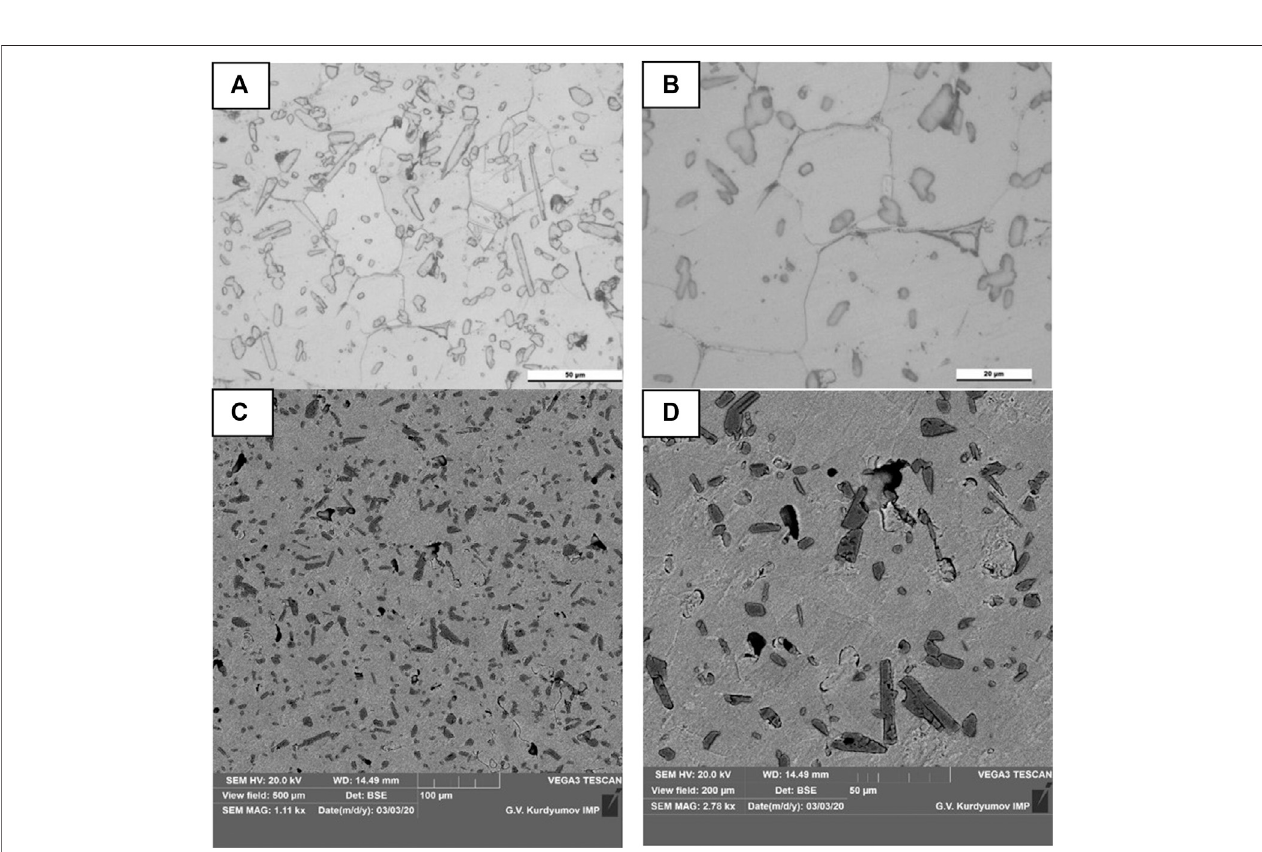
FIGURE 7 | Low-porosity microstructure of the Ti/8.4 vol% TiB composite after a second sintering stage performed at 1,250 ° C for 4 h.